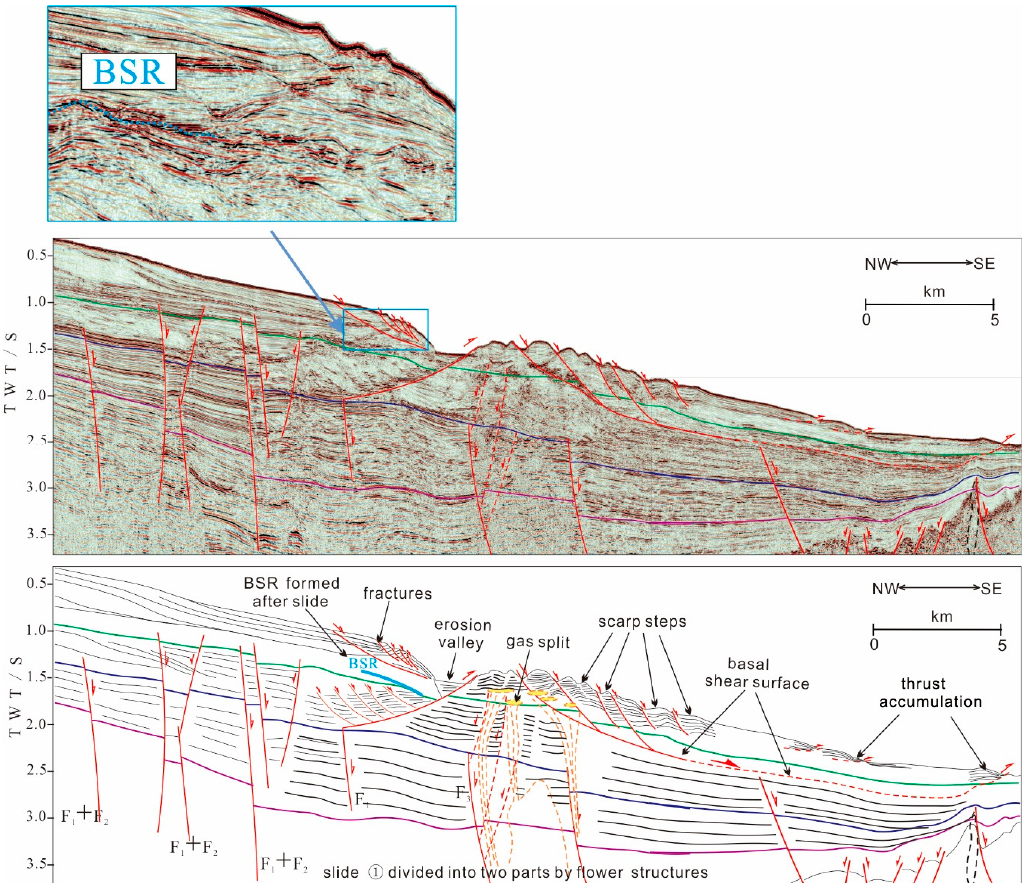
Figure 9. Seismic reflection of Line 8 is a pre-gas hydrate landslide with its interpretation. Energies 2019 , 12 FOR PEER REVIEW